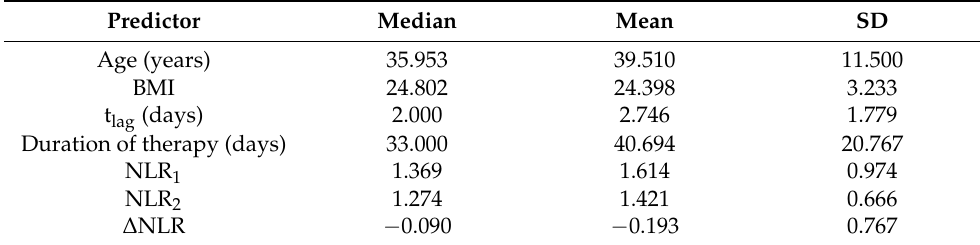
Table 1. Descriptive statistics for continuous variables were included in the study.